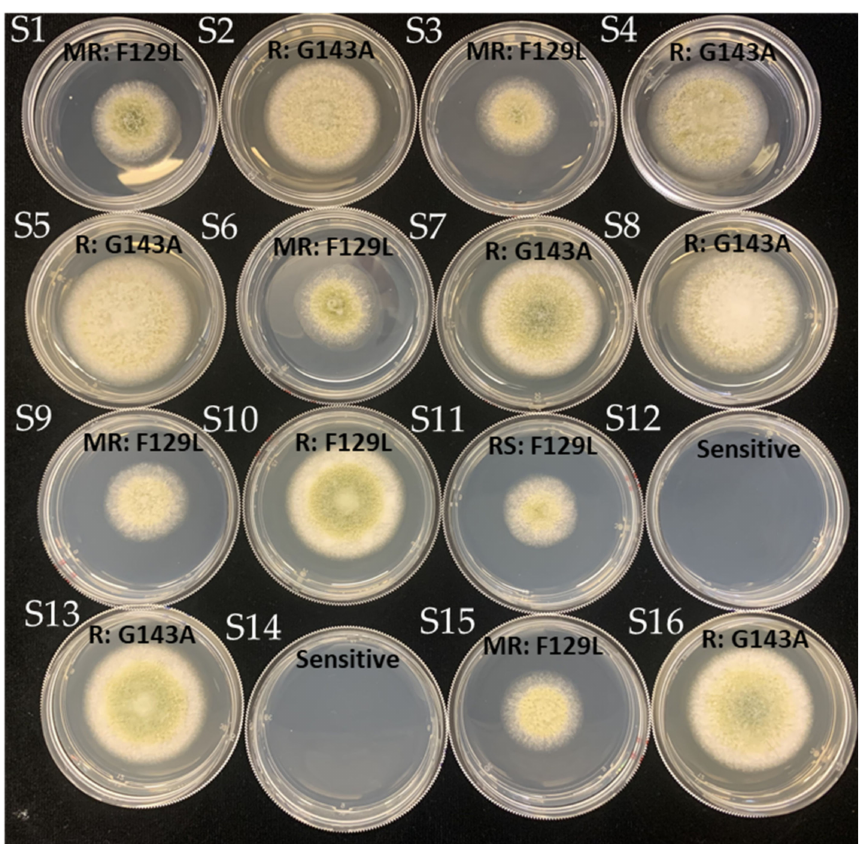
Figure 5. Colony morphology of A. flavus isolates growing on PDA amended with 2.5 ppm azoxys- trobin. Isolates were categorized as either sensitive, reduced sensitivity (RS), moderately resistant (MR), or resistant (R) based on relative growth inhibition ranges.